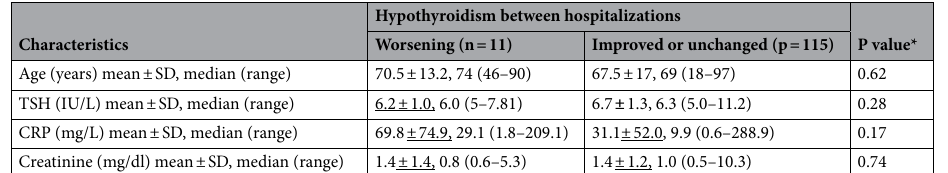
Characteristics